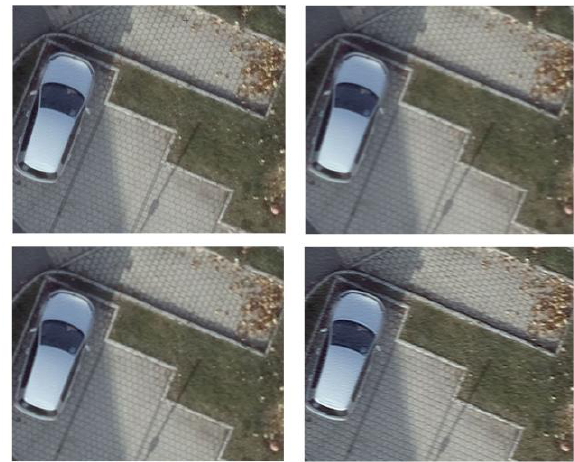
Figure 4: Illustrating the concept of a deconvolution based on a known PSF. From upper left to lower right: original image, blurred image (motion blur at a direction of 20°), restored image making use of the proper PSF (lower left) and the image processed by incorrect parameters.